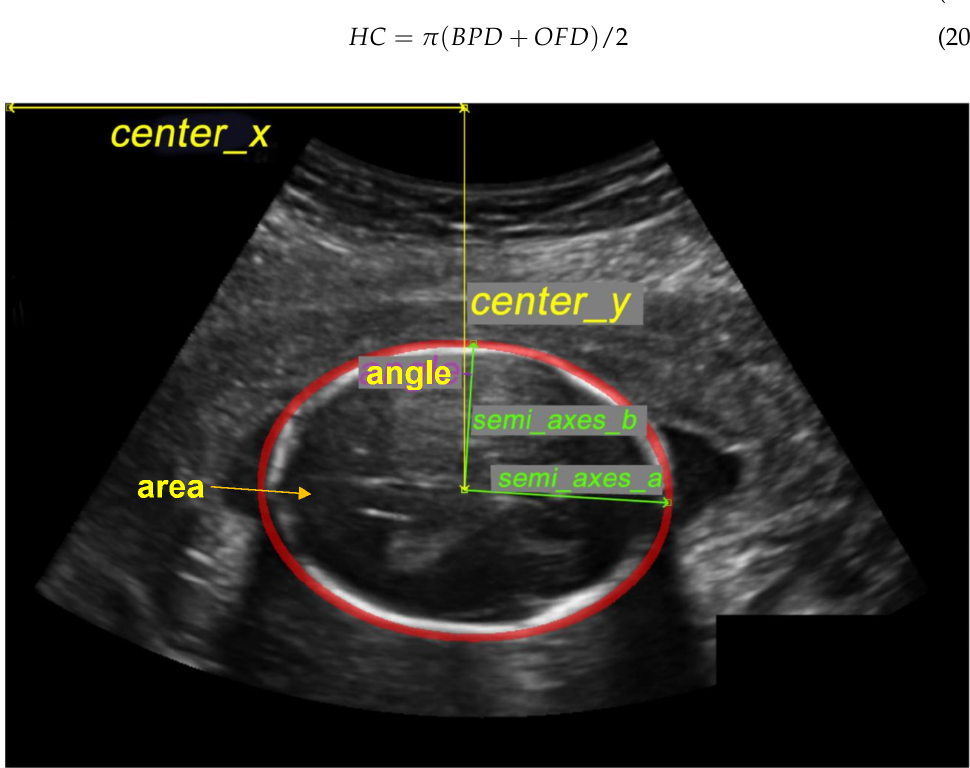
Figure 4. Illustration of the fetal head measurement.